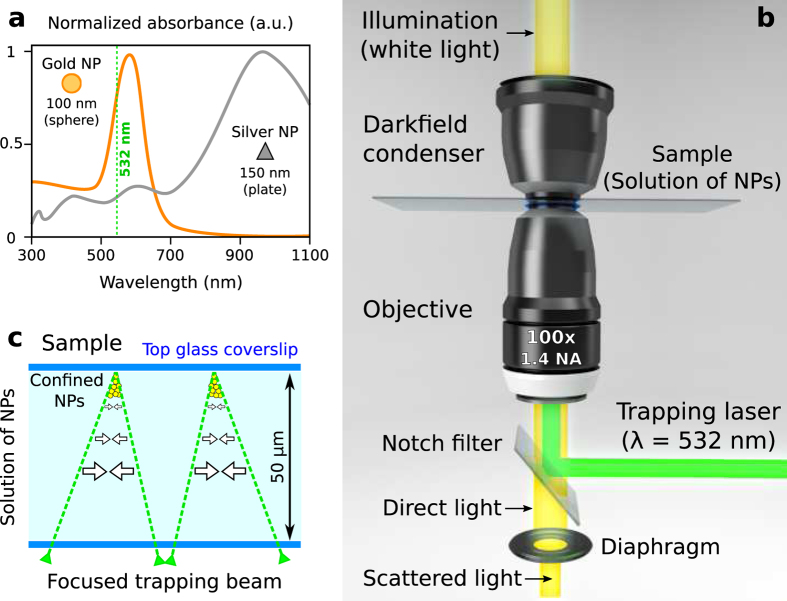
(a) Spectral absorbance of silver and gold NPs. The trapping laser was focused over the sample (colloidal solution of NPs) as sketched in (b). Dark-field illumination was applied to image the NPs by using the same objective lens required for the focusing of the trapping beam. (c) The NPs are confined (by transverse phase gradient forces, white arrows) near the top glass coverslip enclosing the sample (thickness of 50 μm).